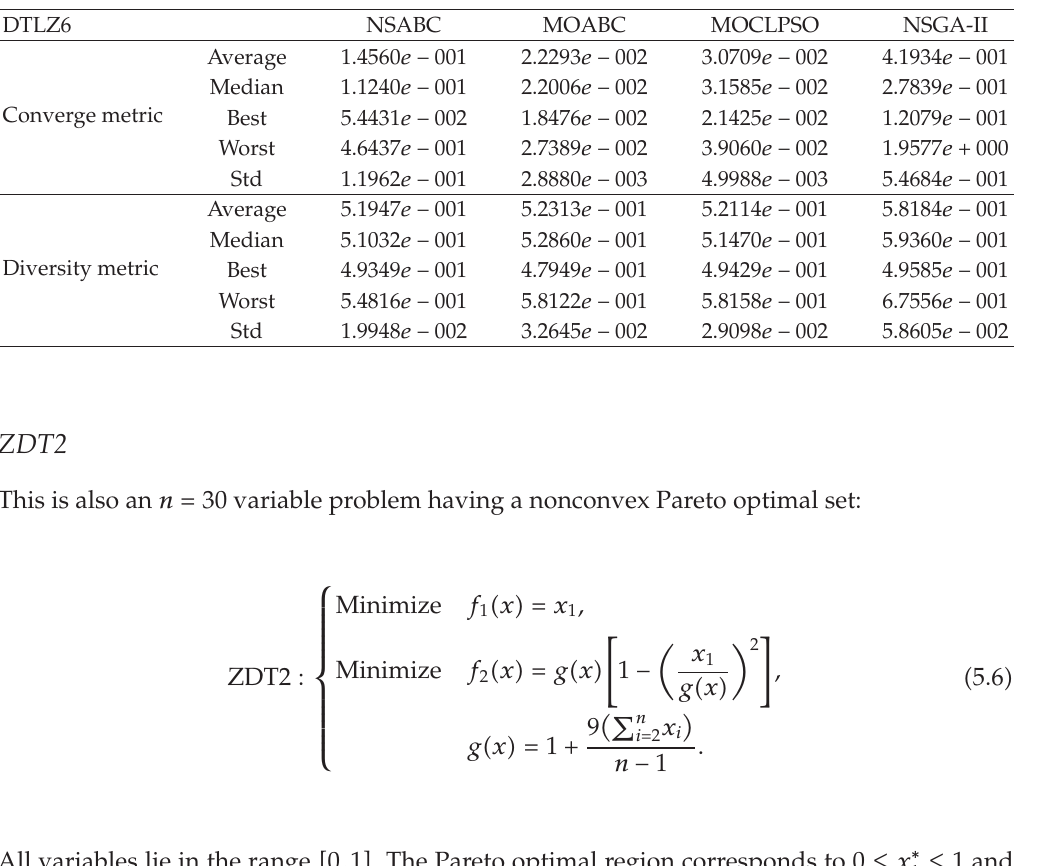
Table 22: Comparison of performance on DTLZ6 after 20000